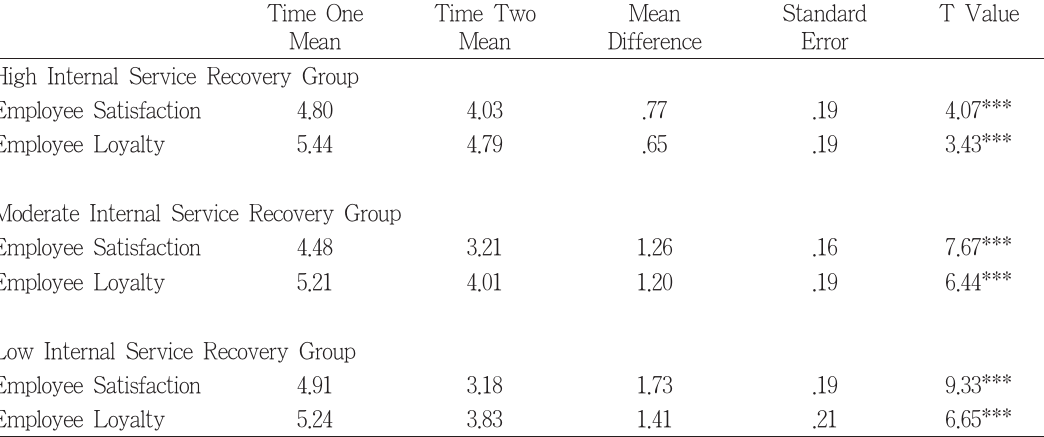
<Table 1> Paired Sample t-tests between Time One and Time Two: Manipulation